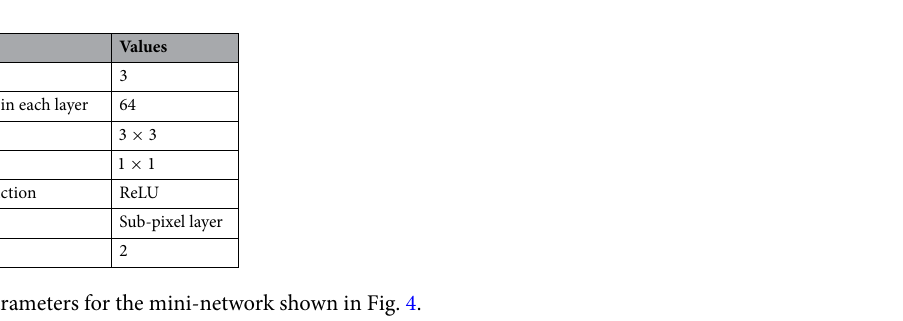
Table 3. Parameters for the mini-network shown in Fig.